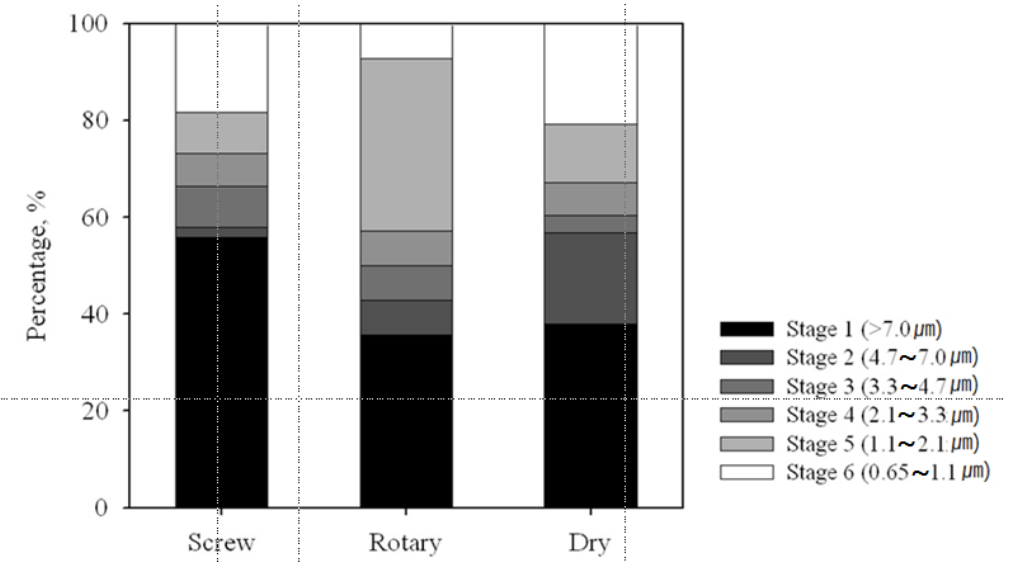
Figure 3. Size distribution characteristics of airborne bacteria in swine manure composting plants.